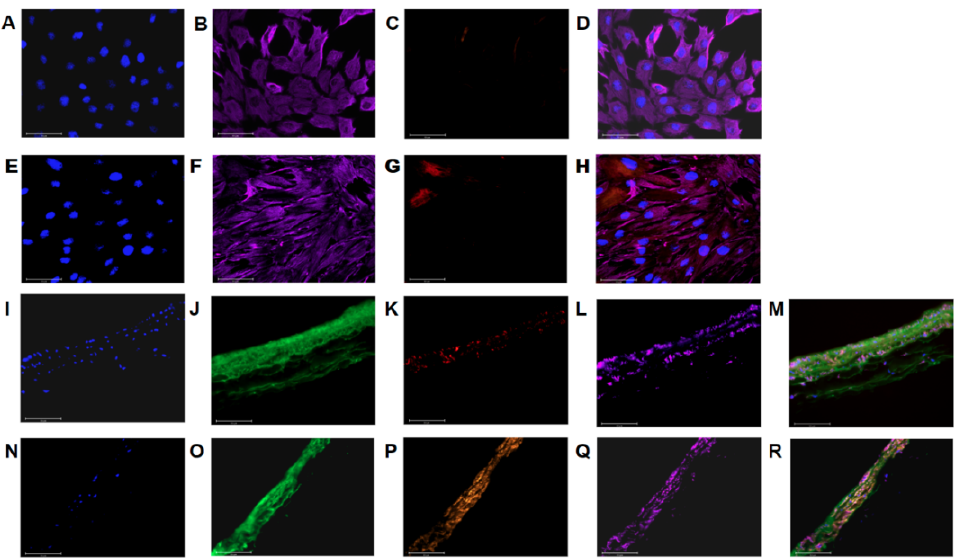
Figure 2. The cell culture showed positive labeling for ( A , E ) DAPI, ( B , F ) vimentin, ( C ) vWF, and ( G ) MYH11 with ( D , H ) overlays. Out of 425 isolated cells, 3% expressed vWF, and out of 888 cells, 0.2% expressed MYH11 and 100% expressed vimentin with representative images shown in ( A – H ). Immunostained PA tissue sections showed positive labeling for: ( I ) DAPI, ( J ) WGA, ( K ) vWF, (red), and ( L ) vimentin(magenta) with an ( M ) overlay. Separate immunostained PA tissue sections showed positive labeling for: ( N ) DAPI, ( O ) WGA, ( P ) MYH11 (orange), and ( Q ) vimentin (magenta) with an ( R ) overlay. These samples were used as labeling controls to estimate purity of a cell culture expanded on plastic. Images were all acquired at 40× magnification, scale bar 50 µm.